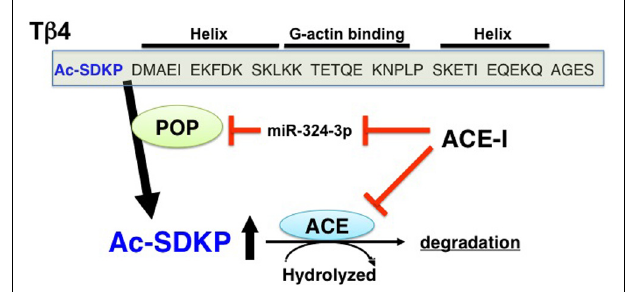
FIGURE 1 | Synthesis and metabolism ofAcSDKP. T β 4, a G-actin binding peptide, is cleaved by POP, and subsequently its N-terminal tetrapeptide, AcSDKP, is synthesized. AcSDKP is hydrolyzed and degraded by ACE. ACE-I may suppress miR-324-3p, which may inhibit protein expression of POP. Therefore, the mechanisms underlying the increased levels of AcSDKP by ACE-I may include both the suppression of degradation pathway and the induction of synthesis pathway of AcSDKP.